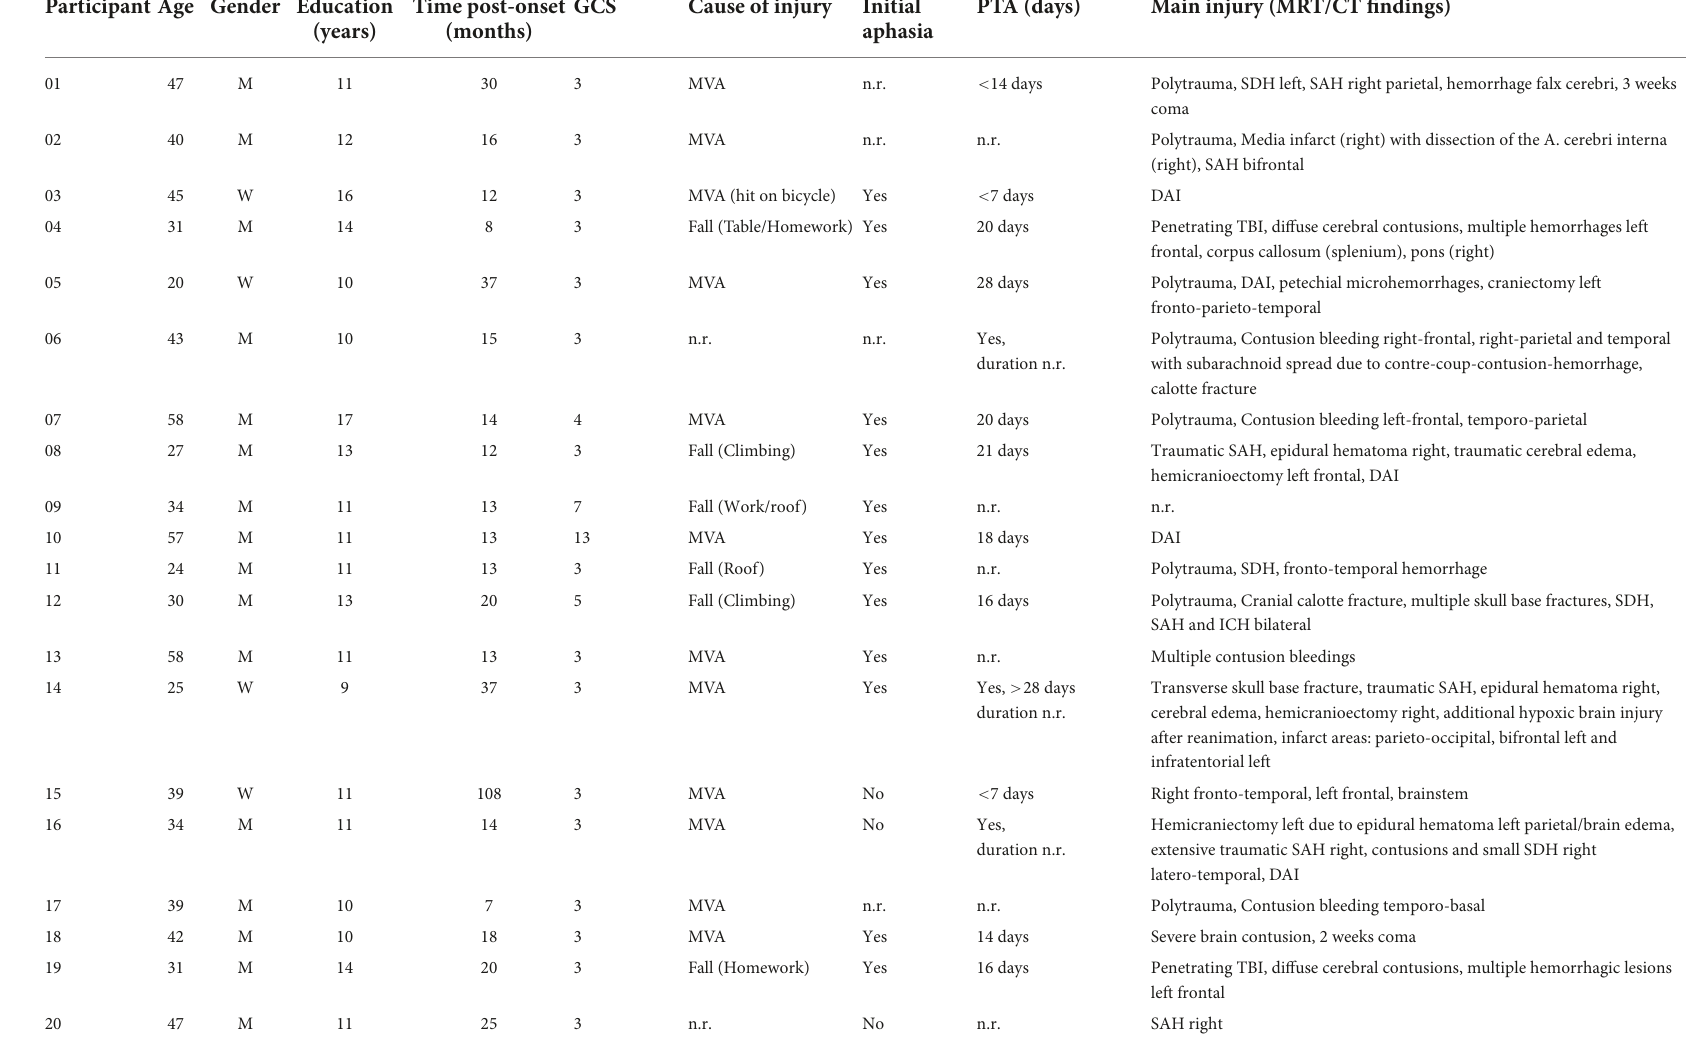
TABLE 1 Background Information of participants with